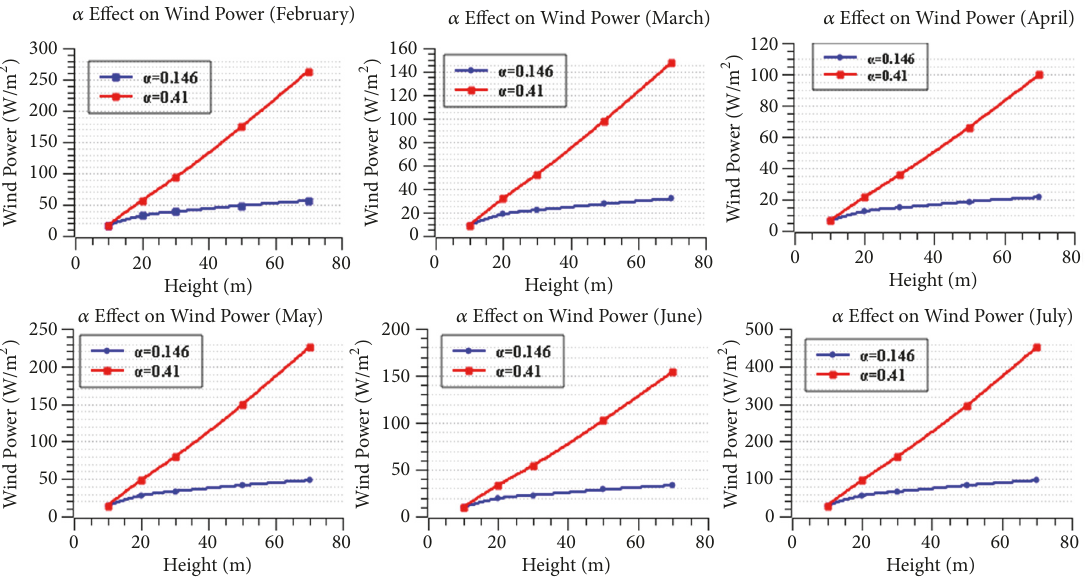
Figure 4: Effect of wind shear exponent on wind energy yield for Kisii University station.